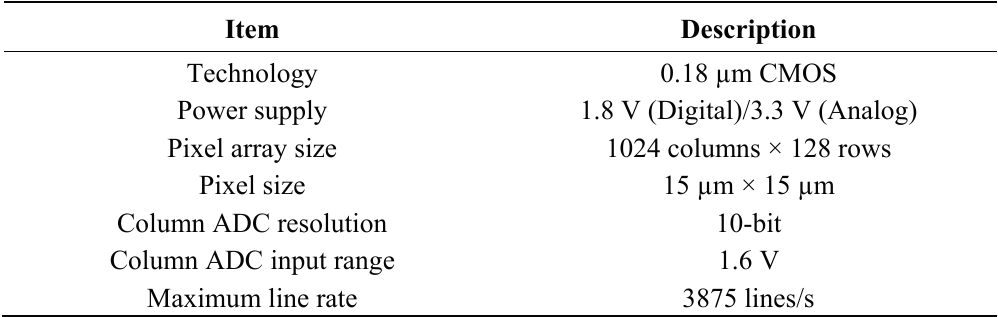
Table 1. Specifications of the